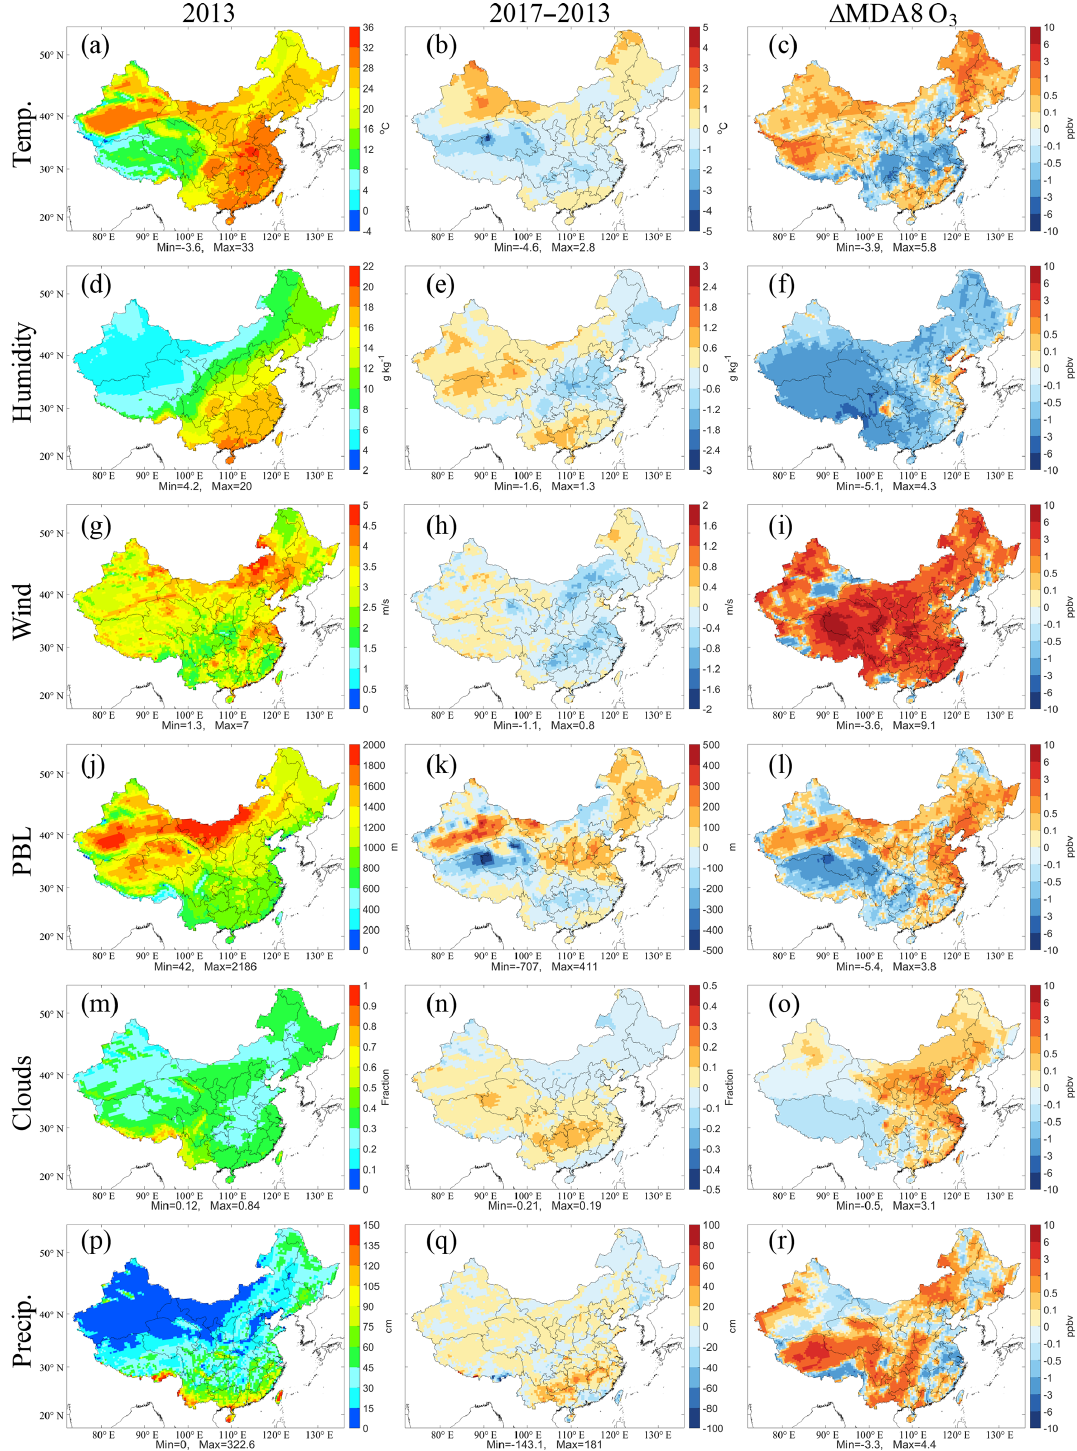
Figure 6. The simulated averaged temperature (Temp.) and specific humidity (Humidity) at a height of 2m, wind speed at a height of 10m (Wind), planetary boundary layer (PBL) height, total clouds fraction (Clouds), and accumulated precipitation (Precip.) in the daytime in summer of 2013 from the base simulation (the left column) and their changes in 2017 relative to 2013 (the central column). The right column shows the changes in simulated summer surface MDA8 O 3 mixing ratios due to variations in temperature, specific humidity, wind fields, PBL height, clouds, and precipitation in 2017 relative to